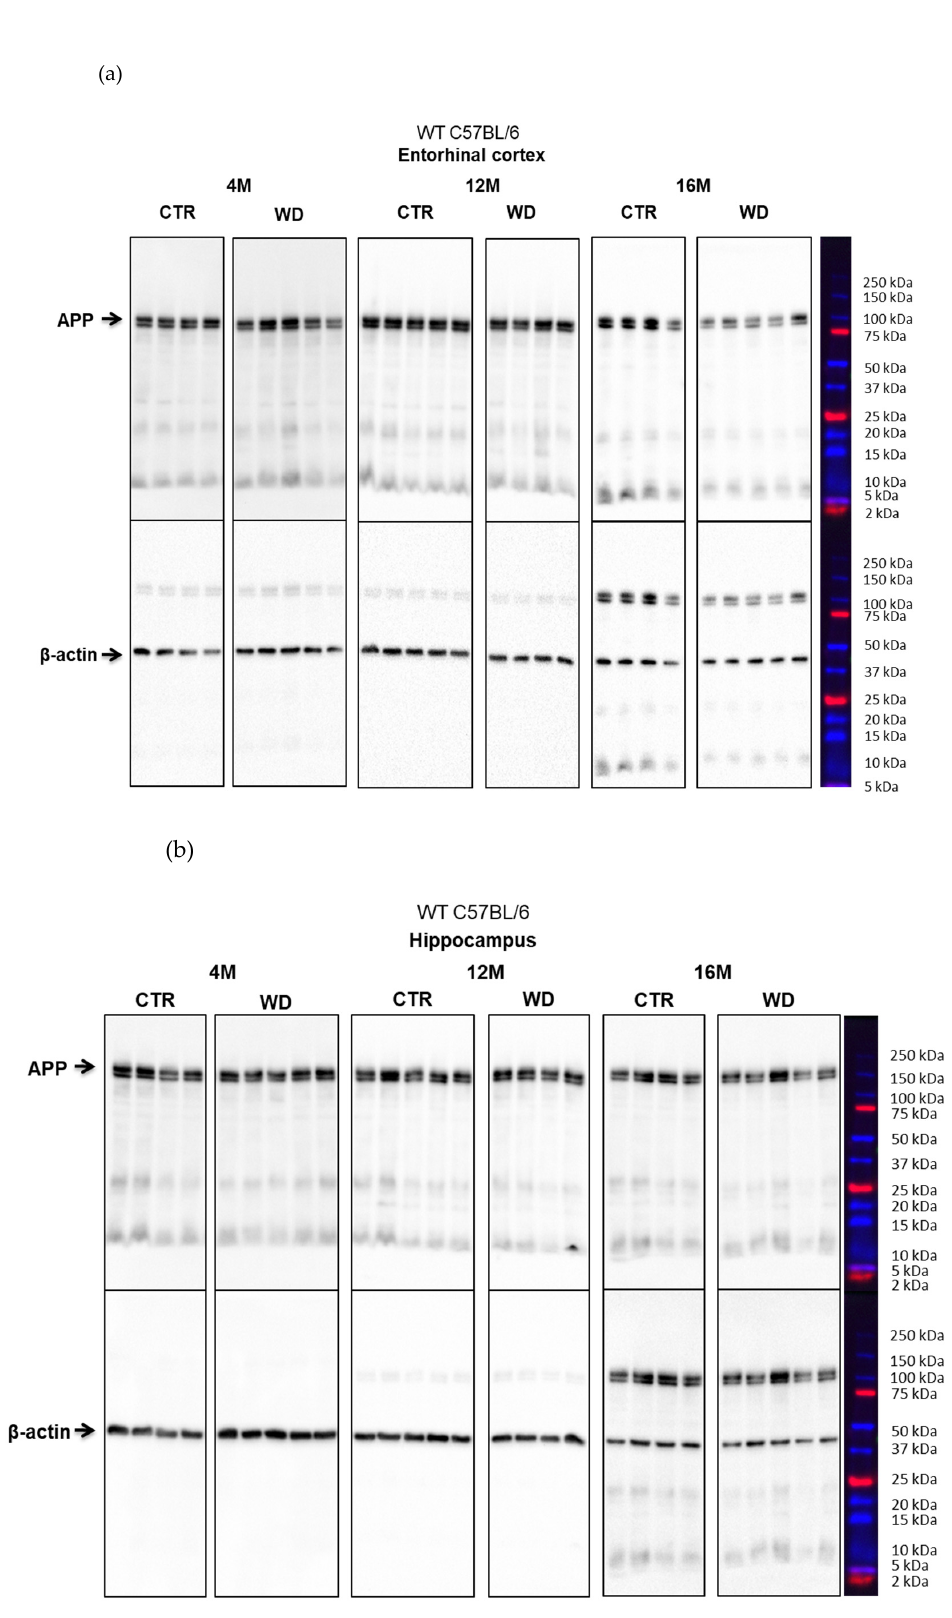
Figure A3. ( a ) The level of APP normalized to β -actin, in the entorhinal cortex of WT C57BL/6J mice (Section 2.3). ( b ) The level of APP normalized to β -actin, in the hippocampus of WT C57BL/6J mice (Section 2.3).